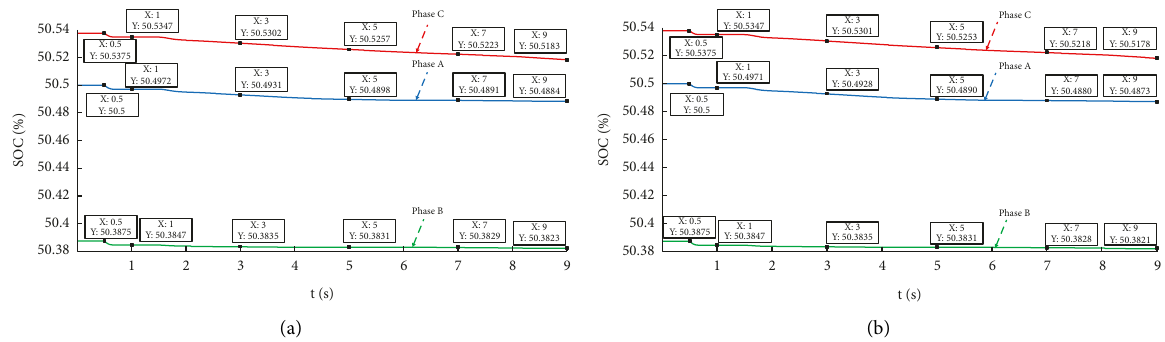
Figure 23: MMC-BESS three-phase SOC average. (a) One-third average method, three-phase SOC average. (b) Sliding window integral method, three-phase SOC